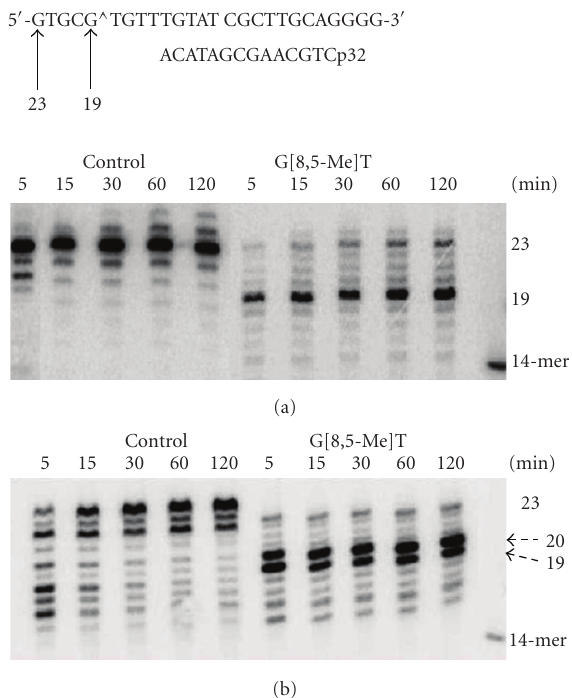
Figure 3: Extension of a 14-mer primer by 50 nM hPol η (a) and yPol η (b) on control and G[8,5-Me]T templates in the presence of all four dNTPs for the indicated time at 37 ◦